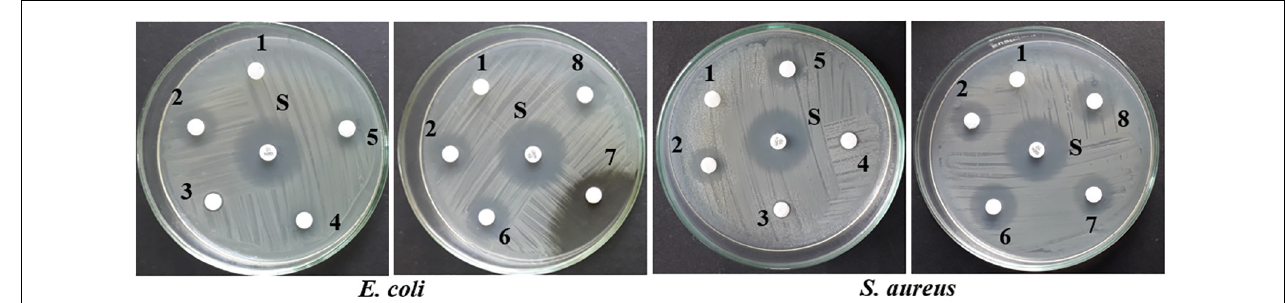
FIGURE 4 | Antibacterial activity of crude EtOAc extract isolated from treated and untreated control cultures of N. sphaerica . Negative Control (1), Control without treatment (2), 5-azacytidine (3), Valproic acid (4), Hydralazine Hydrochloride (5), Sodium butyrate (6), Quercetin (7), and SAHA (8). TABLE 3 | Volatile organic secondary metabolites reported for biological activity. Sl. No. Cryptic